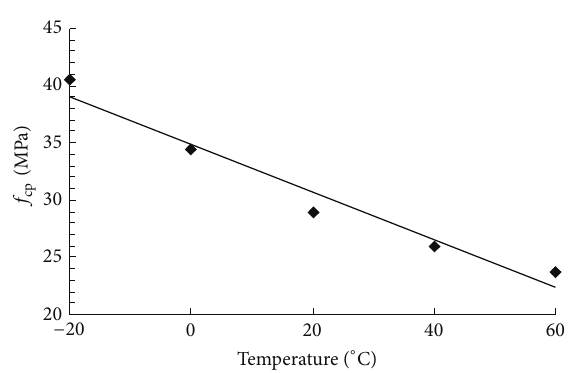
Figure 8: Temperature effect on prism compressive strength. Table 4: Modulus of elasticity for concrete under different temper- atures.